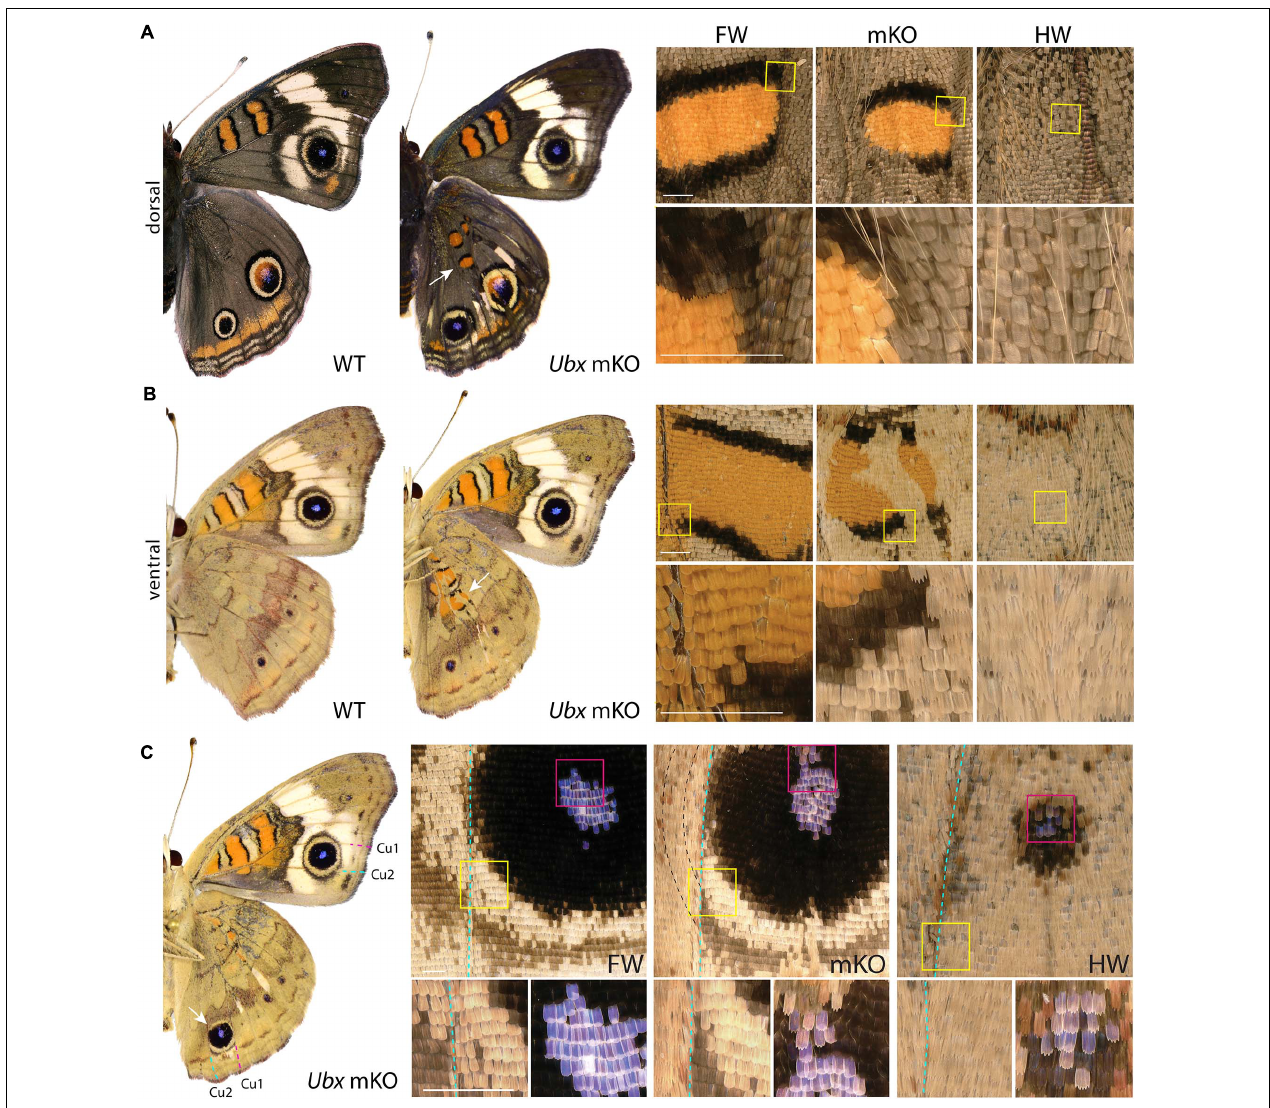
FIGURE 1 | Ubx mosaic knock-outs show homeotic transformations of hindwing color patterns in J. coenia . Insets depict homeotic hindwing (HW)-to-forewing (FW) mutant patterns [mosaic knock-out (mKO), center column]. (A,B) Dorsal and ventral views of WT and an example Ubx mKO J. coenia , with insets showing the Discalis I pattern element. (C) Example of a ventral Cu1-Cu2 eyespot homeosis; mutant cells stopped at the Cu2 vein (dashed line), and non-mutant cells across that clone failed to induce outer rings. Scale bars = 500 µ